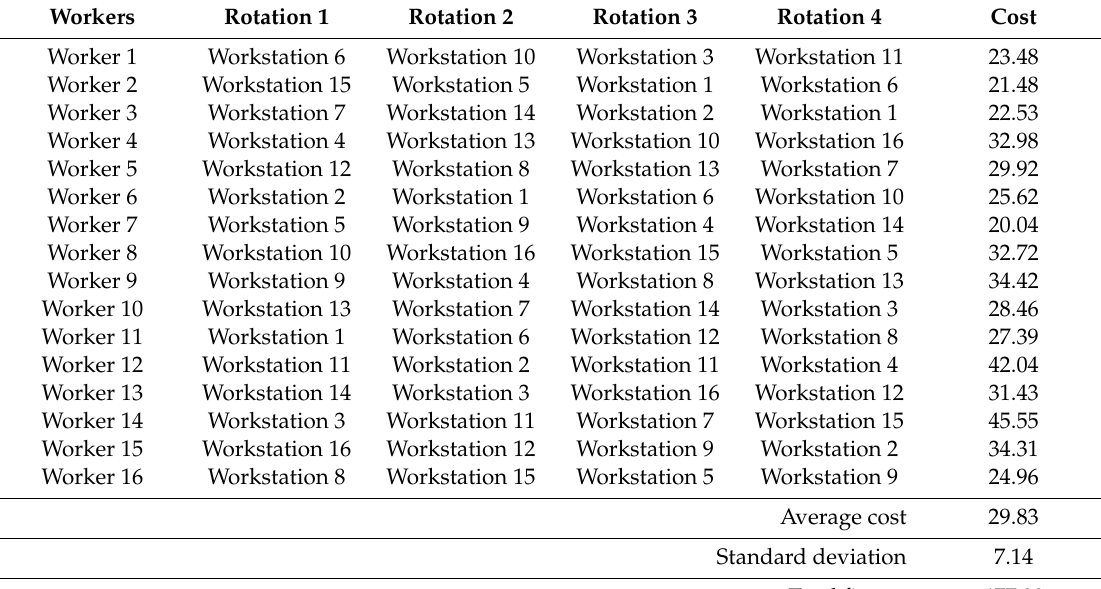
Table 8. Best solution generated by